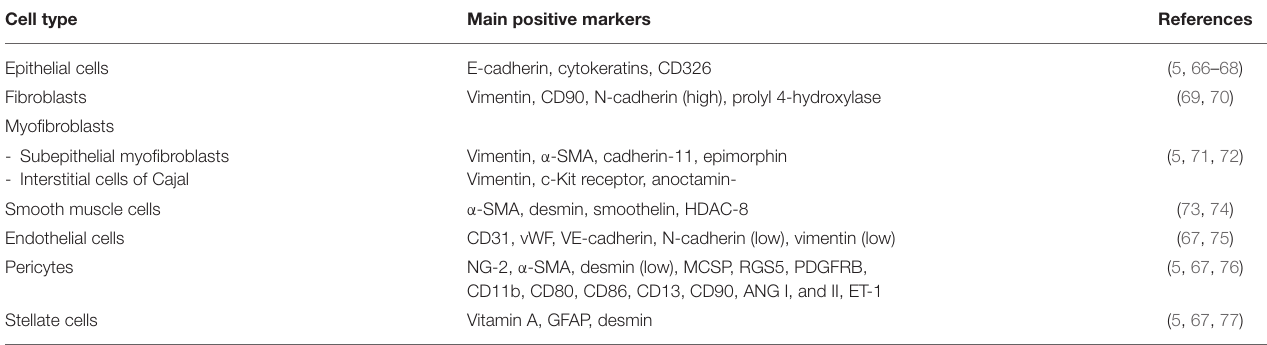
TABLE 4 | Intestinal ECM-producing cell